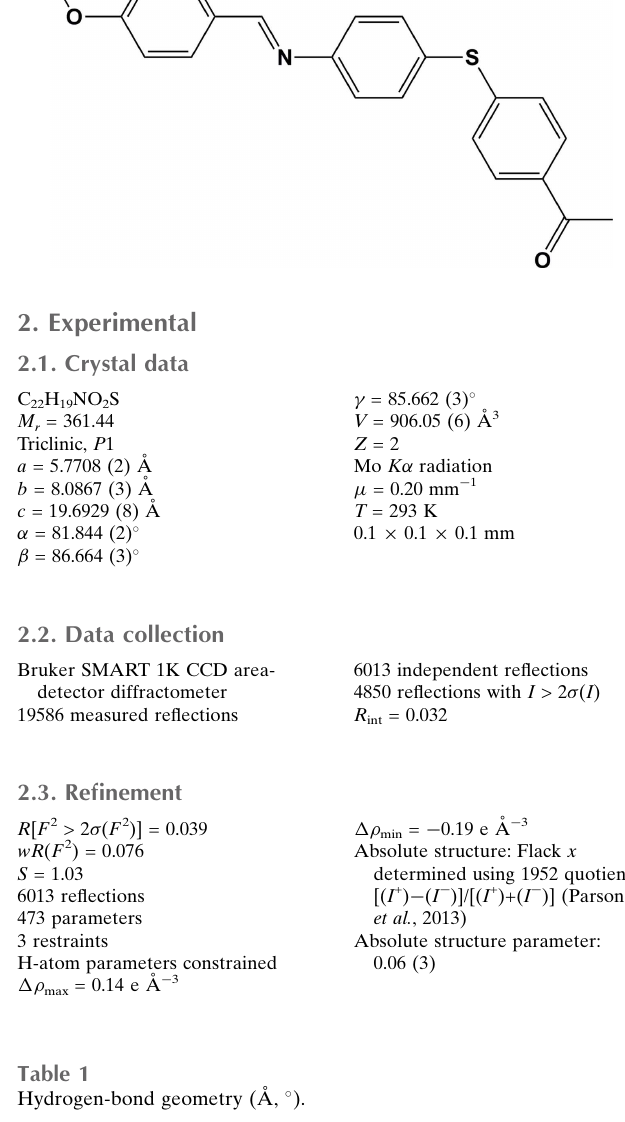
Hydrogen-bond geometry (A˚ , (cid:2)